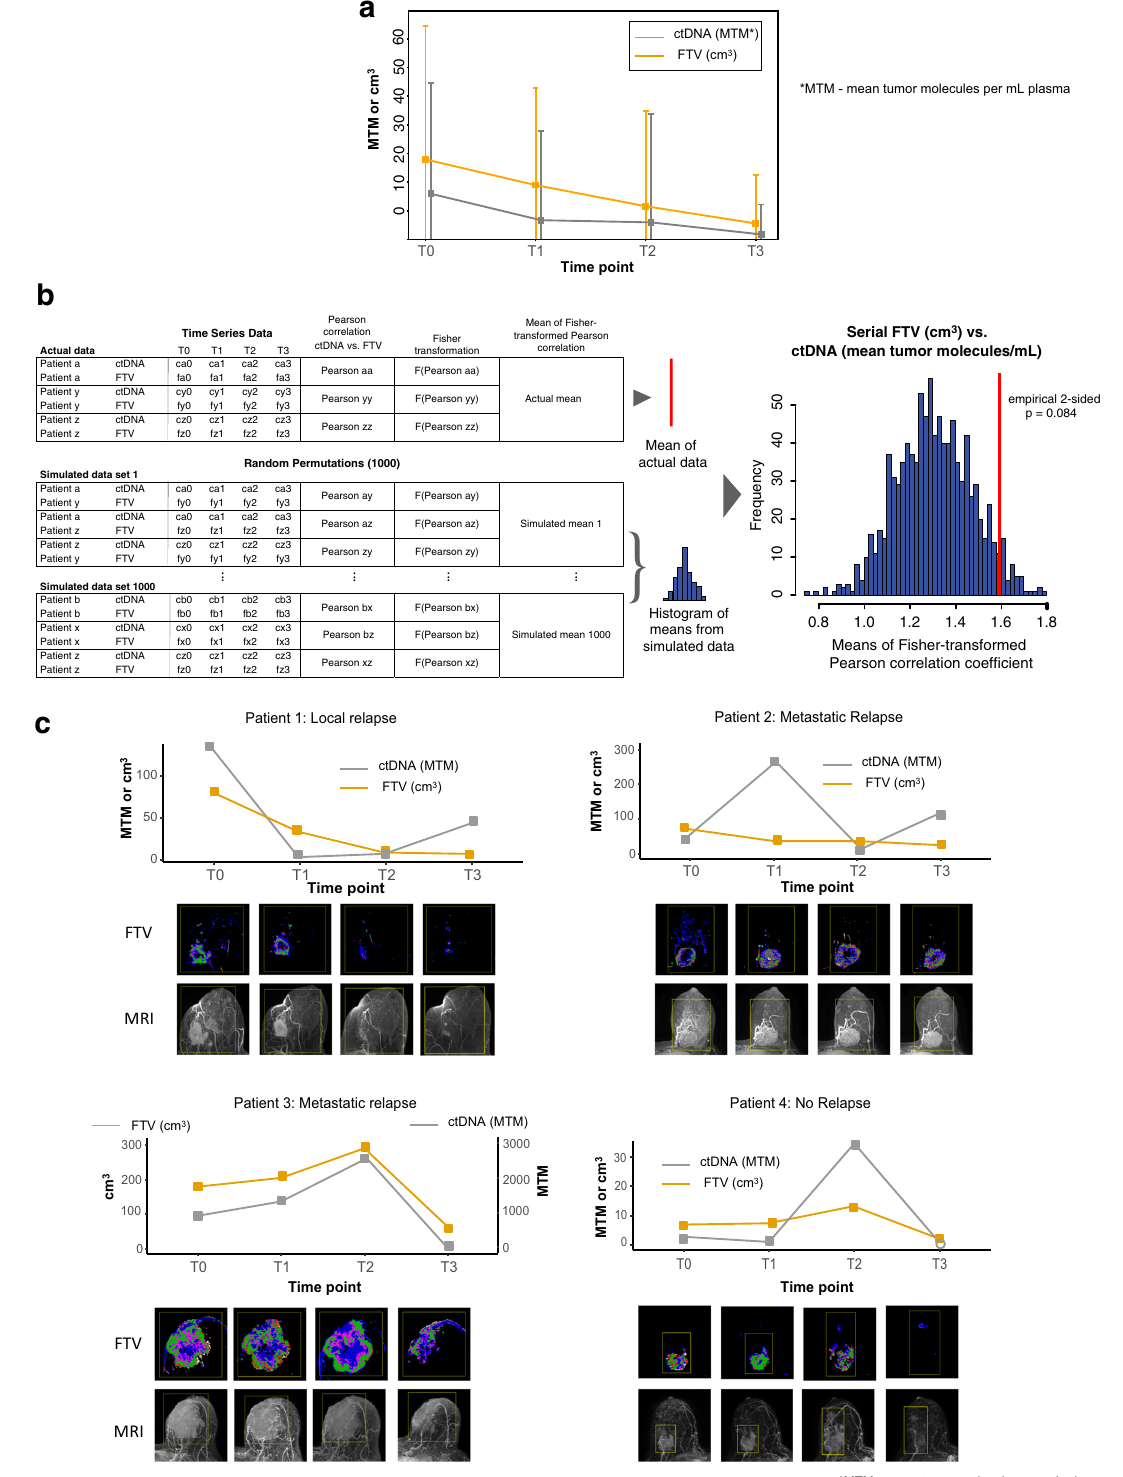
Fig. 3 Correlation between ctDNA and MRI-based FTV dynamics during NAC. a Mean levels of ctDNA (mean tumor molecules per mL plasma, MTM) and FTV (cm 3 ) across time points. The error bars represent standard deviation. The vertical lines represent standard deviation. b Schematic for calculating the mean Pearson correlation for actual data and means for simulated datasets using Monte Carlo method. The right panel is histogram showing the distribution of simulated means of Fisher z-transformed Pearson ’ s correlation coef fi cient. The red line corresponds to the mean Fisher z-transformed Pearson ’ s correlation coef fi cient calculated based on the actual data. c Plots showing ctDNA (mean tumor molecules per mL plasma, MTM) and FTV (cm 3 ) levels across time points in 4 representative cases. Un fi lled dot at T3 in patient 4 indicates ctDNA below the limit of detection. T0: pretreatment; T1: 3 weeks after initiation of paclitaxel-based treatment; T2: between paclitaxel and anthracycline regimens; T3: after NAC prior to